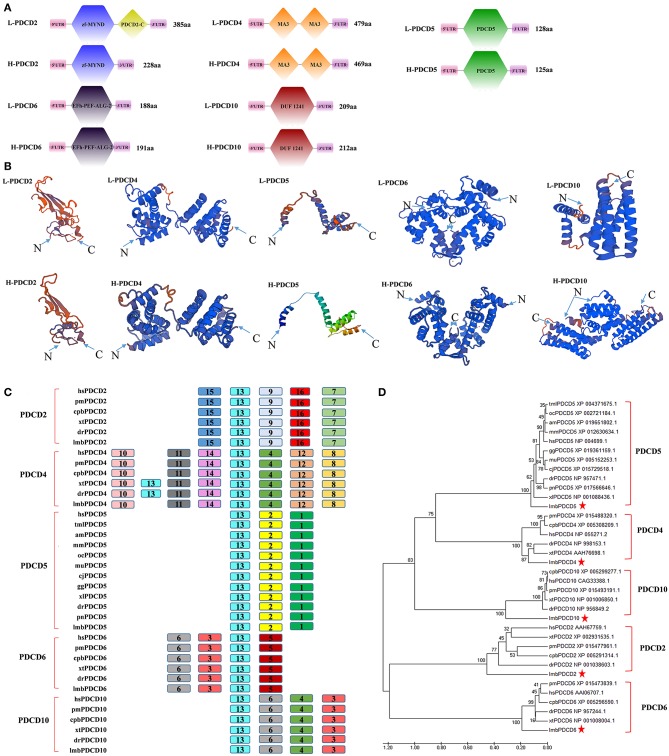
The identification and sequence analysis of PDCD family genes. (A) A comparison of the domains between PDCD2, PDCD4, PDCD5, PDCD6, and PDCD10. (B) Tertiary structure prediction of PDCD2, PDCD4, PDCD5, PDCD6, and PDCD10 from humans and lampreys. (C) A motif composition of the PDCD family proteins. The motifs, which are numbered 1-16, are shown in different colored boxes. (D) The phylogenetic tree for the PDCD family based on the NJ method. An NJ tree was constructed using the amino acid sequences of the PDCD proteins. The numbers at the nodes indicate the bootstrap confidence values derived from 1000 replications. hs, Homo sapiens; lmb, Lampetra morii berg; pm, Parus major; cpb, Chrysemys picta bellii; xt, Xenopus tropicalis; dr, Danio rerio; tml, Trichechus manatus latirostris; oc, Oryctolagus cuniculus; am, Ailuropoda melanoleuca; mm, Microcebus murinus; gg, Gavialis gangeticus; mu, Melopsittacus undulatus; cj, Coturnix japonica; pn, Pygocentrus nattereri; and xl, Xenopus laevis. The bar (0.020) indicates the genetic distance.